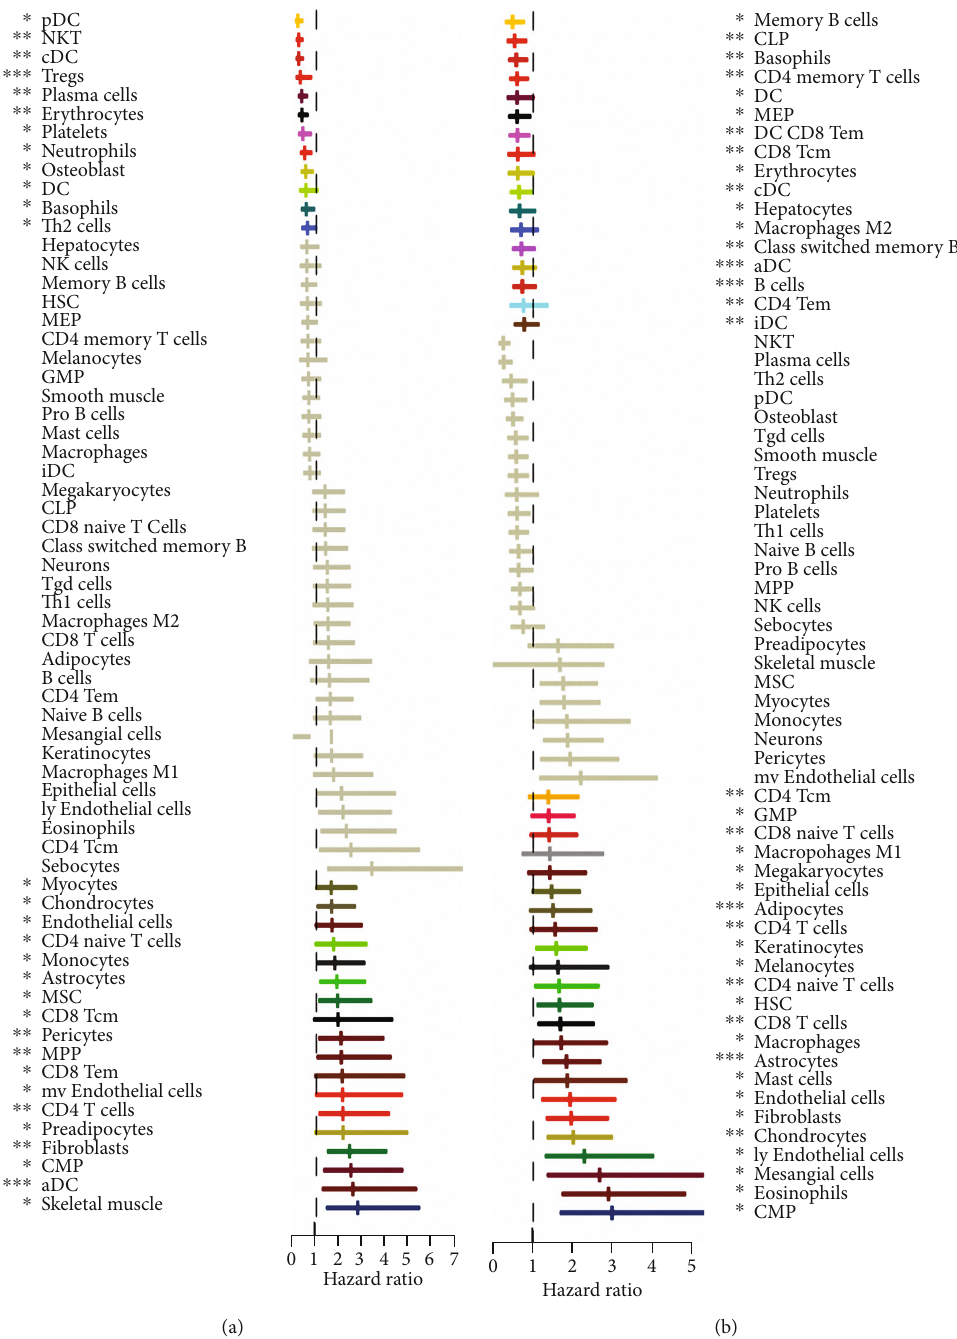
Figure 2: Correlations of the 64 types of cells with the survival of CRC patients. (a) Forest plot showed the associations of the 64 cell types and OS. (b) Forest plot showed the associations of the 64 cell types and